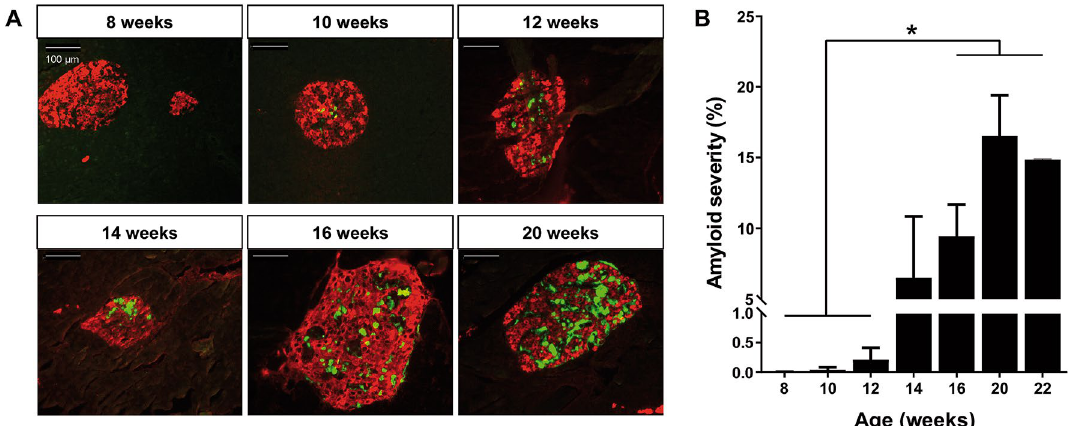
Figure 2. Time course of islet amyloid deposition in A vy hIAPP mice. ( A ) Representative images of pancreatic islets from A vy hIAPP mice at different ages. Pancreas sections were stained with Thioflavin S to study amyloid deposits (green) and an anti-insulin antibody (red). Scale bars, 100 μm. (B) Amyloid severity quantification (percentage of amyloid respect to total islet size). Results are presented as mean ± SEM of 2–5 mice/group. Statistical analyses were performed using one-way ANOVA. *p < 0.05.